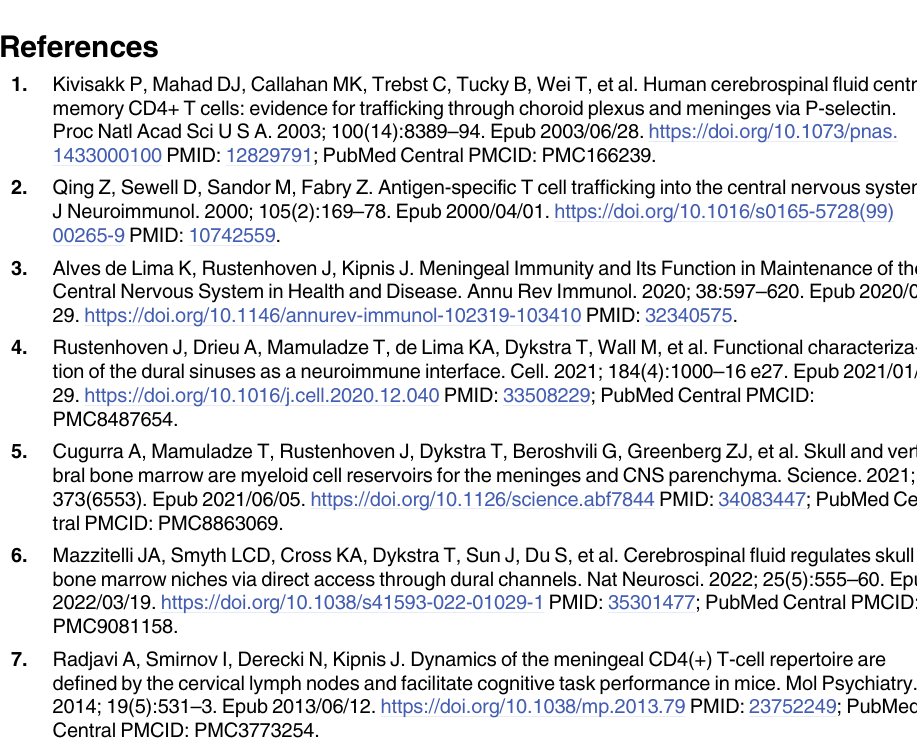
S2 Fig. PCA plots of Rag2 glia. PCA of RNA sequencing data from glia from Rag2 -/- and con- trol mice. Red = female, blue =